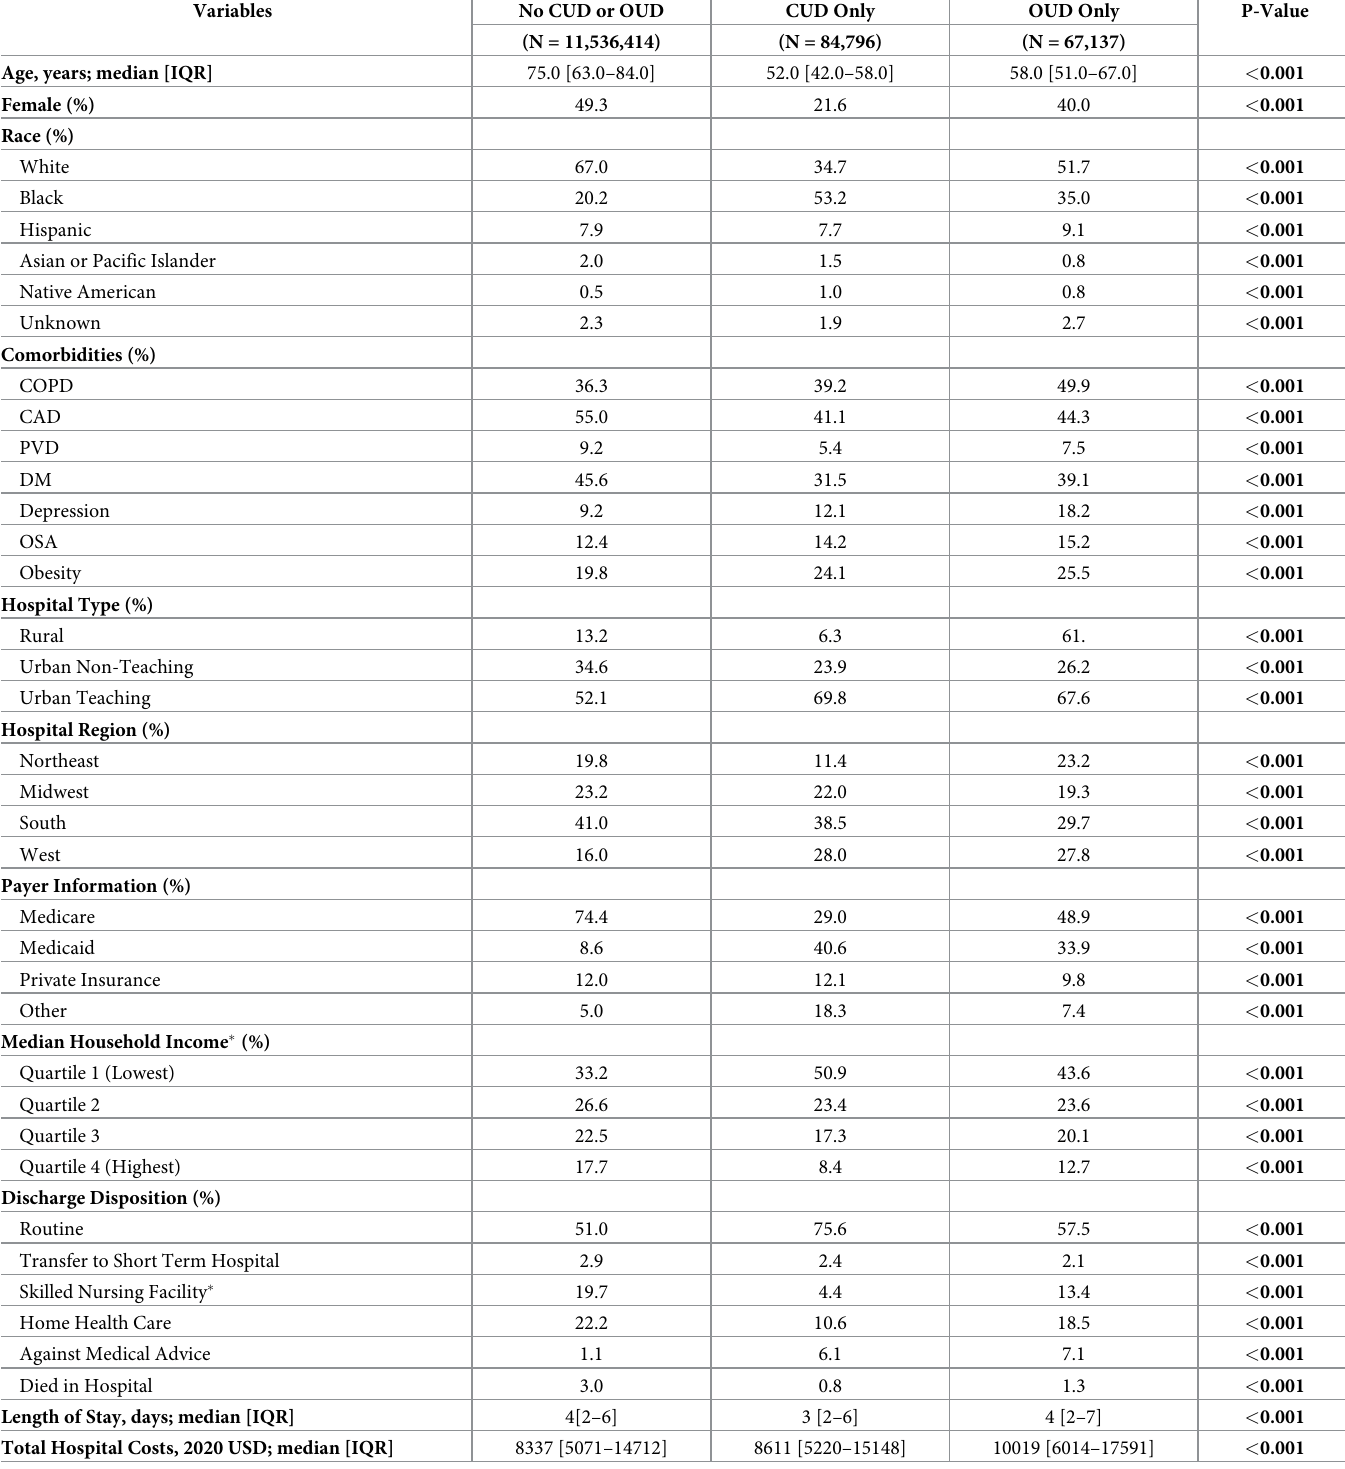
Table 1. Demographics, outcomes, and costs of HF hospitalizations with and without CUD and OUD in the United States from 2008–2018.